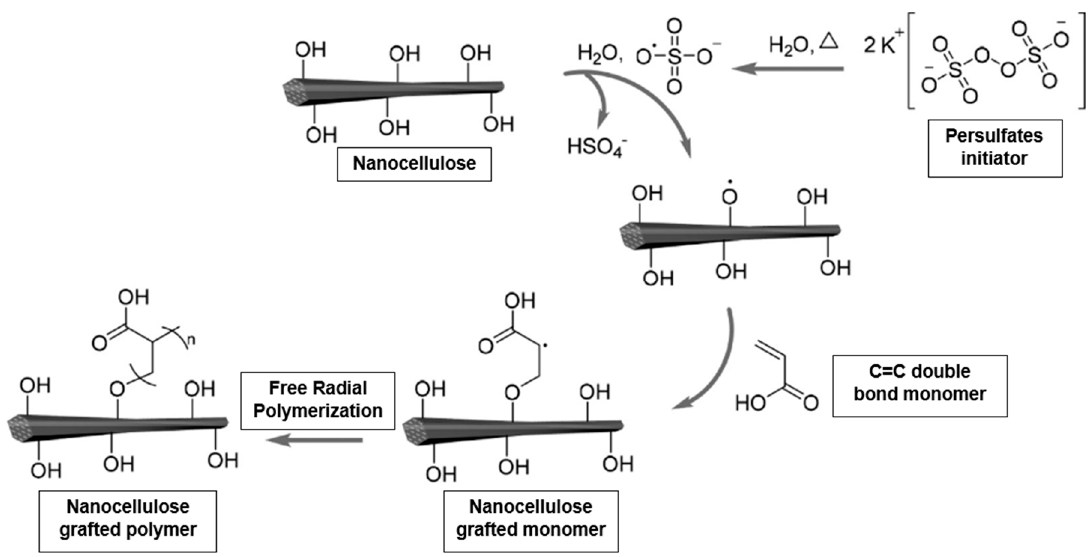
Figure 6. Synthesis of nanocellulose grafted with a monomer via surface-initiated free radical polymerization (modified from [84]).